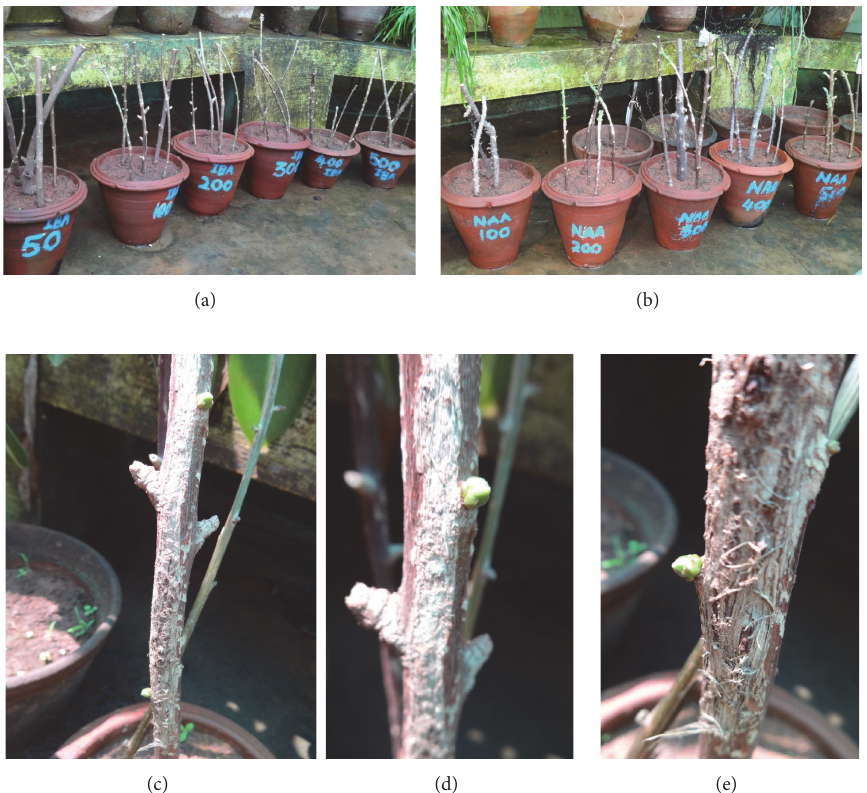
Figure 1: (a) Stem cuttings pretreated with different concentrations of IBA. (b) Stem cuttings pretreated with different concentrations of NAA. (c) IBA pretreated cuttings after 4 weeks. (d) IAA pretreated cuttings after 4 weeks. (e) NAA pretreated cuttings after 4